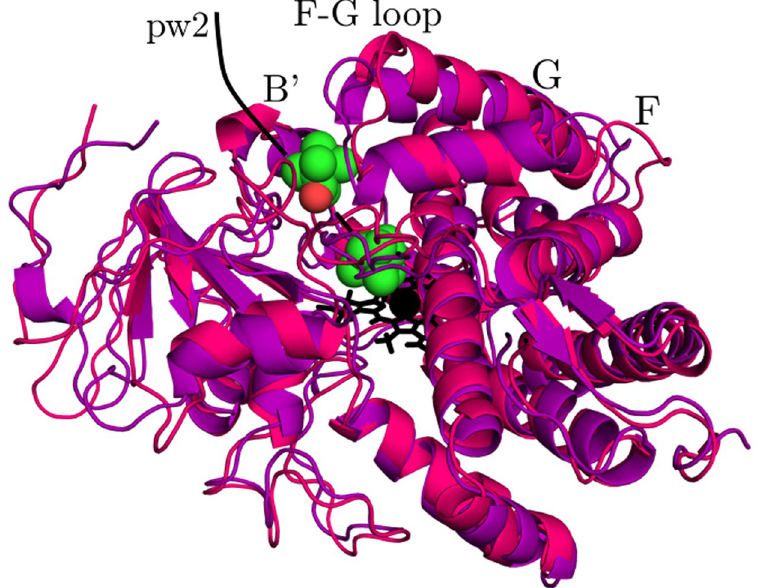
Figure 4. Representative conformations of cytochrome P450cam from the open and closed basins sampled during the diffusion along pw2 in the proximity of the putative substrate recognition site recovered using the multidimensional scaling. The open and closed conformations clustered into the open and closed states by DBSCAN are shown in pink and purple, respectively. The root-mean-square distance between these structures is 3.15